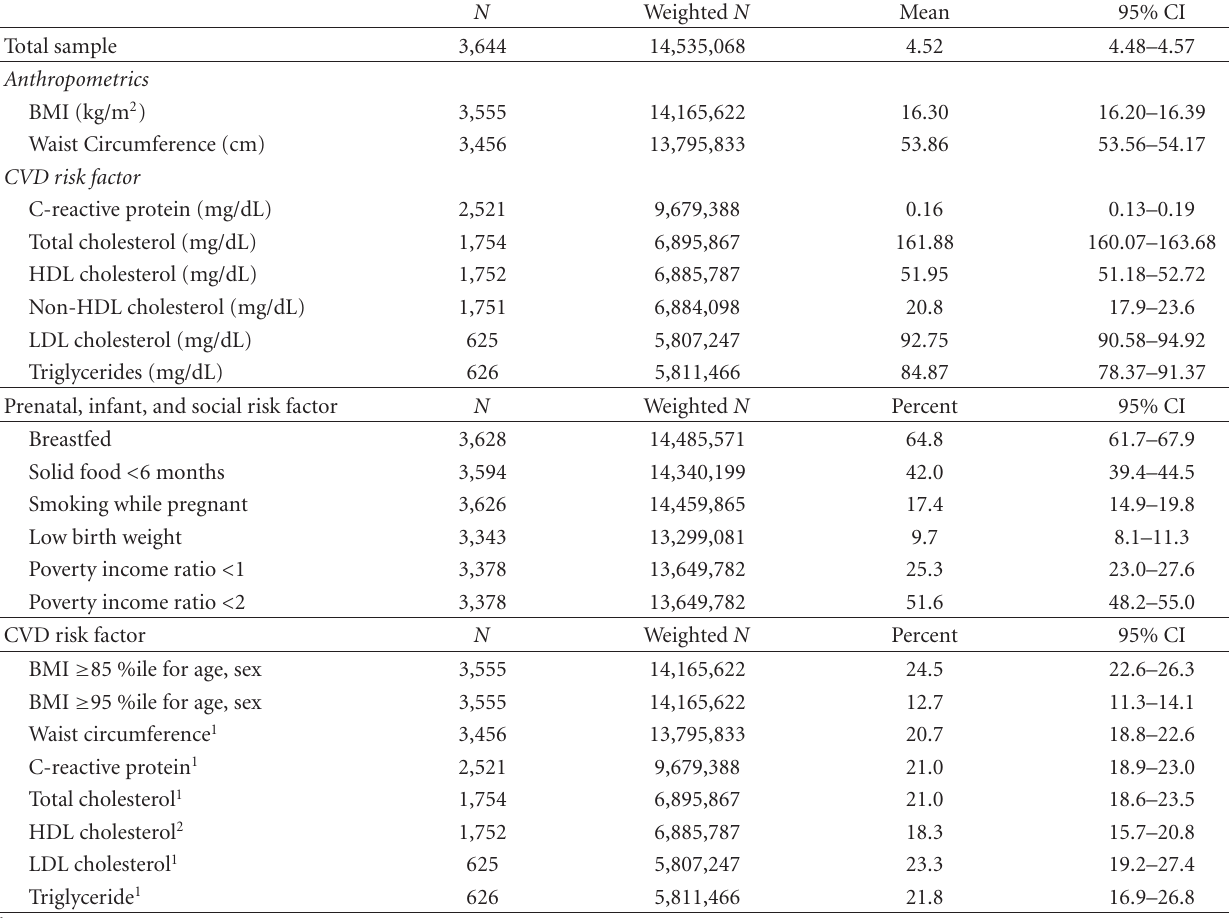
Table 3: Sample, estimated national characteristics, and range of values for measurements in 3,644 3-to-6-year-olds in the National Health and Nutrition Examination Survey,